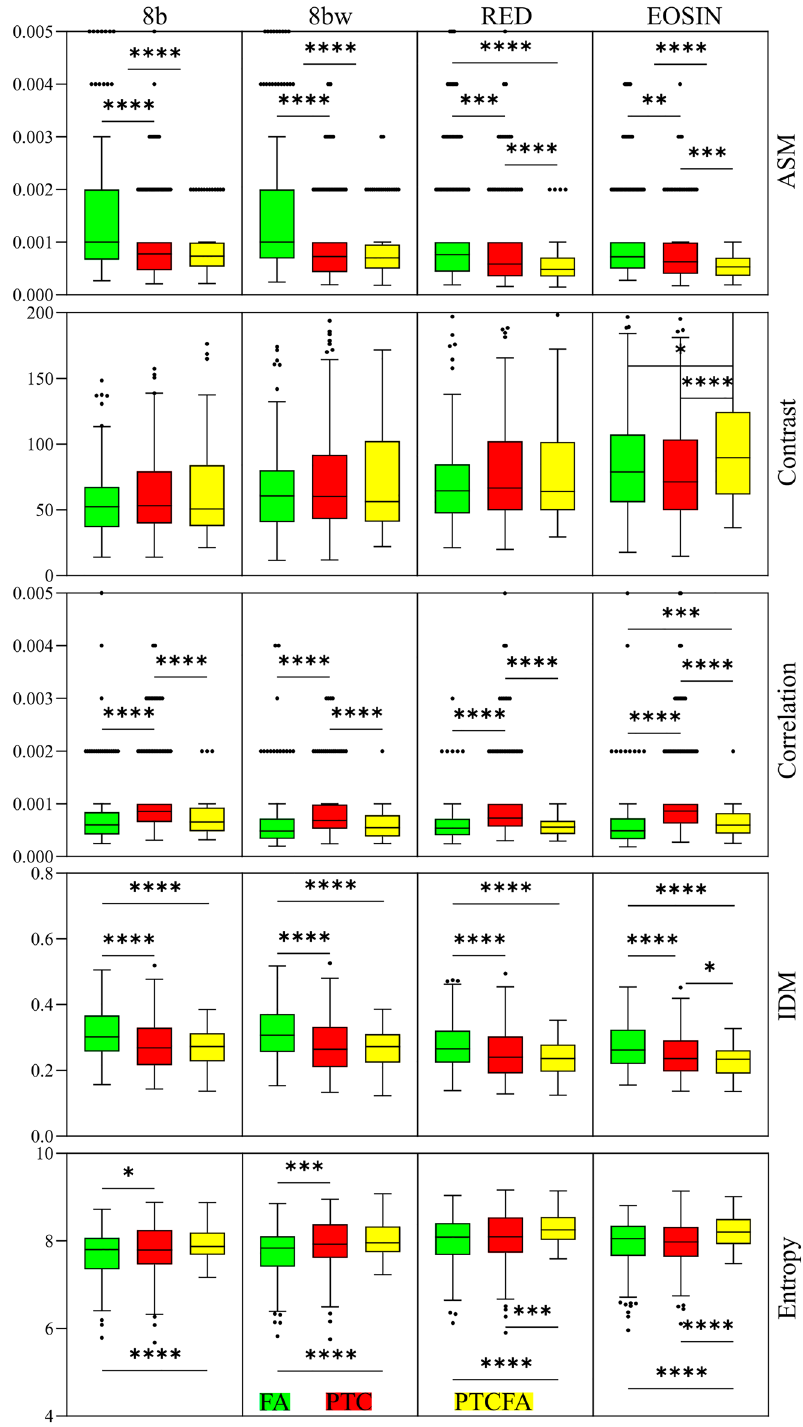
Figure 5. Statistical analysis for the case of GLCM parameters extracted from the 1024 × 1024 pixels image tiles. (* p < 0.05, ** p < 0.01, *** p < 0.001, **** p <